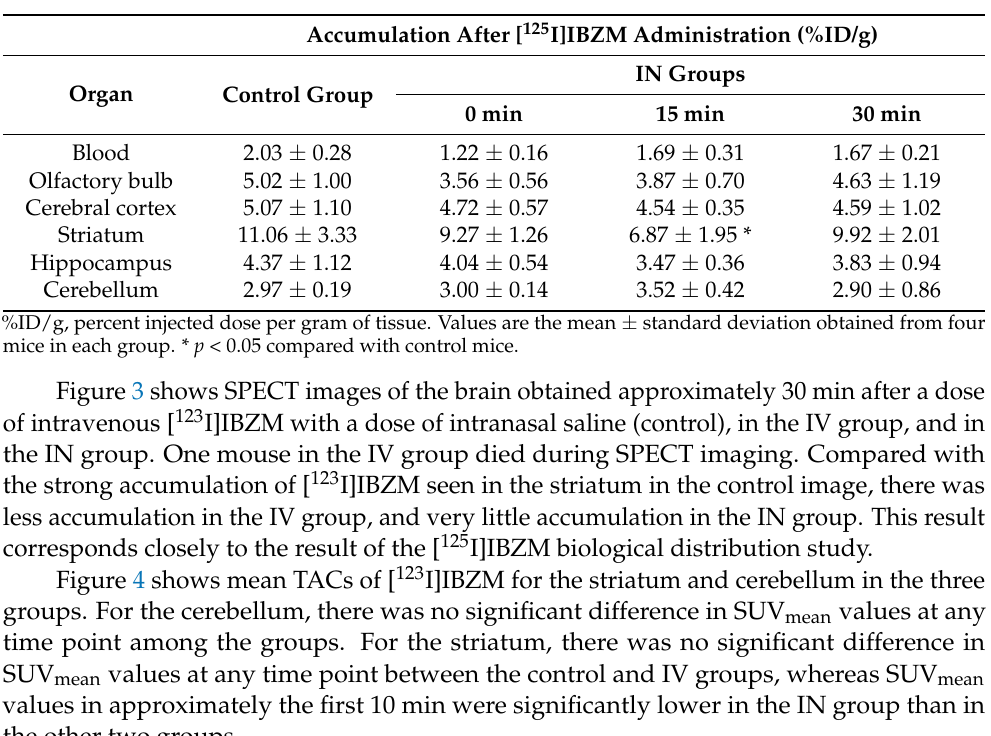
Table 1. Biological distribution of [ 125 I]IBZM in control mice and following intranasal domperi- done